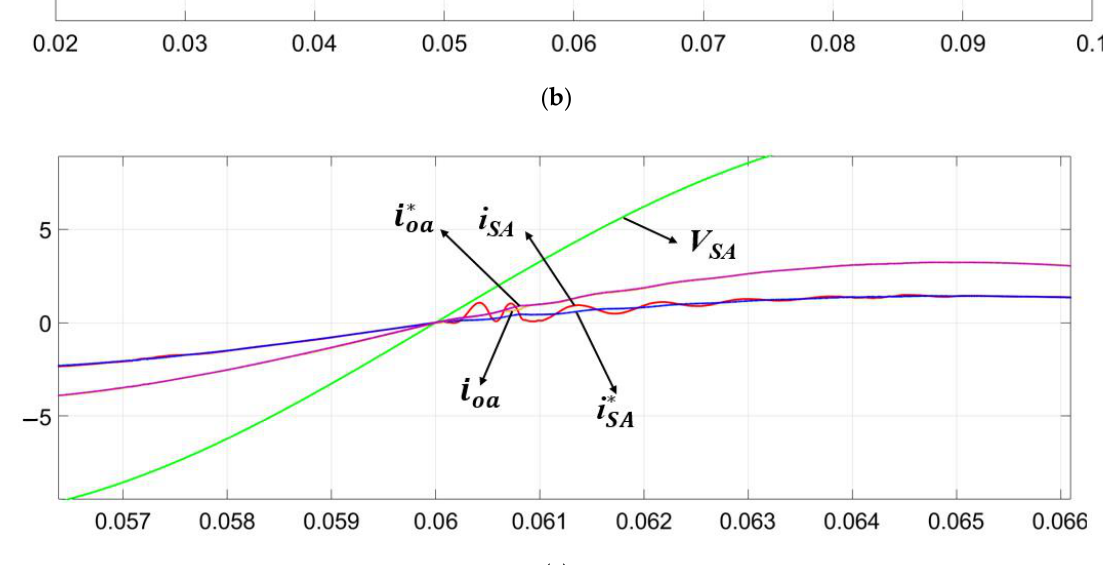
Figure 10. Simulation results of the VMMPC for the TSMC, where output-current reference amplitude steps from 4.3 A to 2.15 A at t = 0.06 s, source voltage V sA /13 V, source-current reference i sA * A, source current i sA A, output current i oa A, and output-current reference i oa * A, x-axis unit second: ( a ) without the IFRS; ( b ) with the IFRS; ( c ) details of the box in Figure 10b.